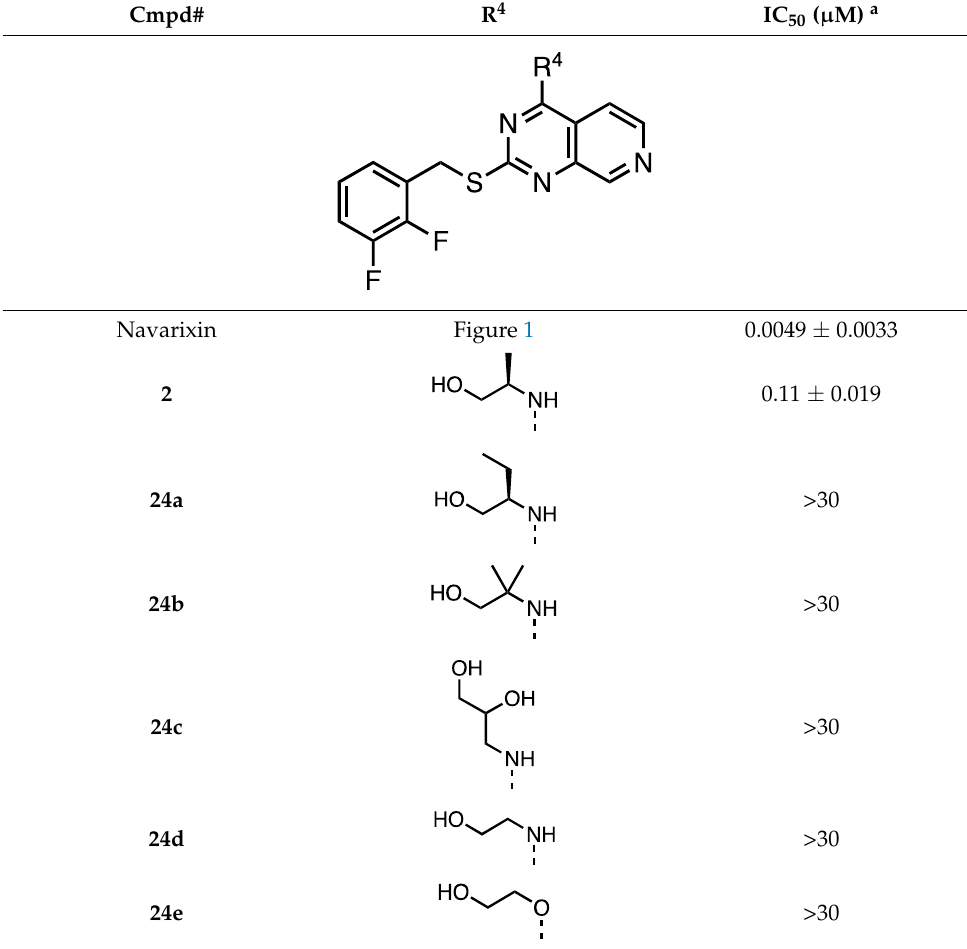
Table 2. CXCR2 antagonism of 4-substituted pyrido[3,4- d ]pyrimidines.